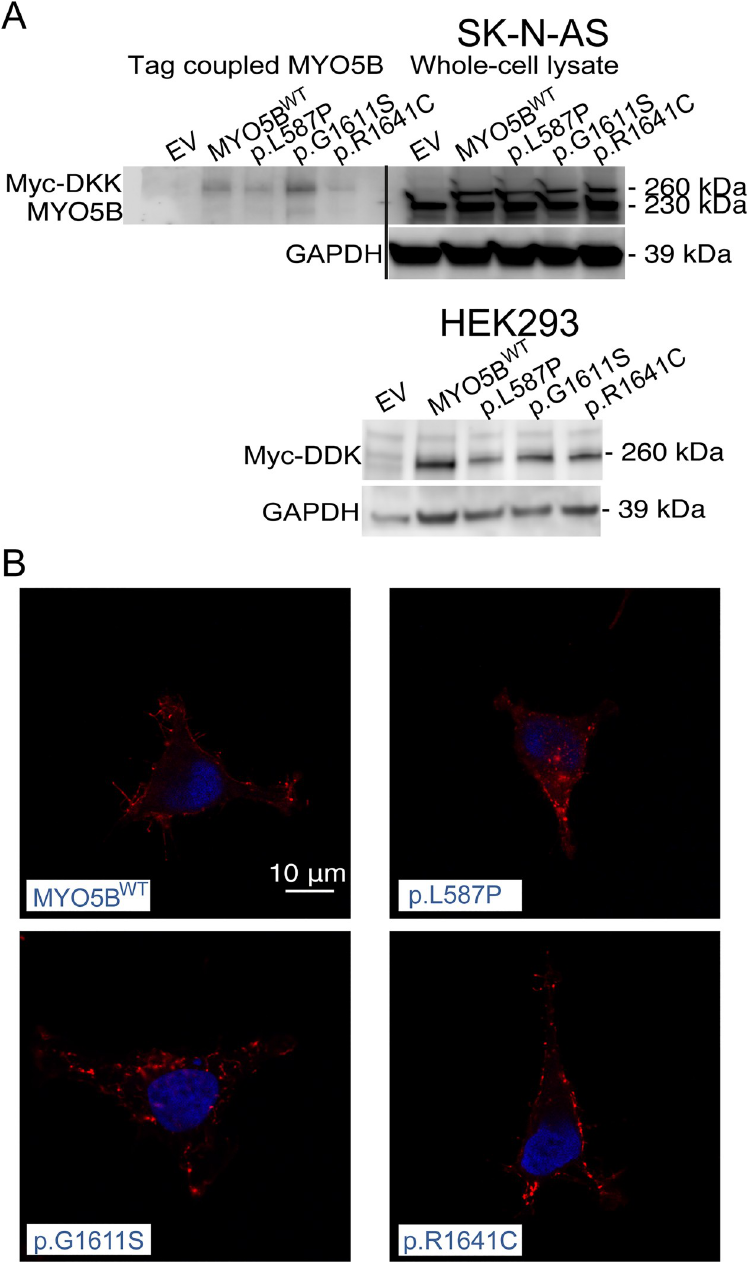
Fig 3. Expression and localization of MYO5B in cell lines. Western blot in SK-N-AS cells (A) showing MYO5B expression in whole cell protein lysate and FLAG M2-antibody coupled lysate (n = 1, top panel). Western Blot using FLAG M2 antibody in HEK293 (n = 1, bottom panel). GAPDH used as loading control. Localization of Myc-DKK (B) in HEK293 (63X, LSM700) in pCMV6-MYO5B_L587P-Myc-DDK (p.L587P), pCMV6-MYO5B_G1611S-Myc-DDK (p.G1611S), and pCMV6-MYO5B_R1646C-Myc-DDK (p.R1641C). Myc-DKK is depicted in red and DAPI staining of nuclei in blue. Scale bar shown is 10 μ